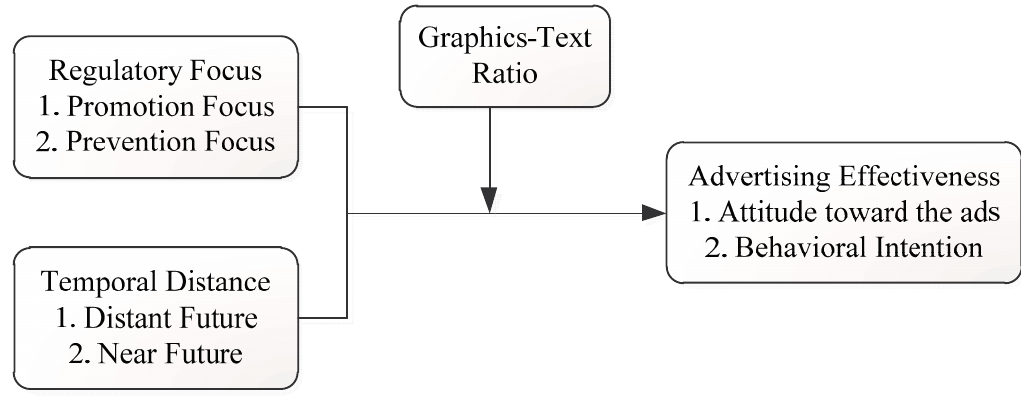
Figure 1 . Research